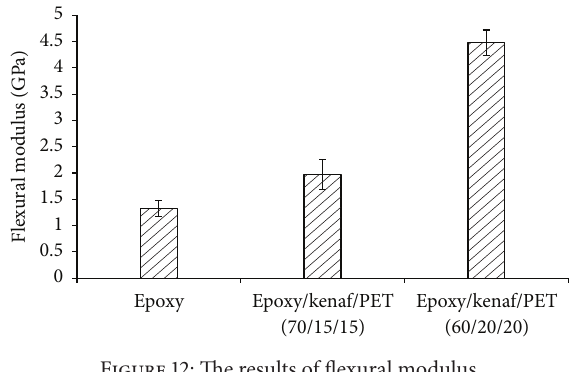
Figure 12: The results of flexural modulus.